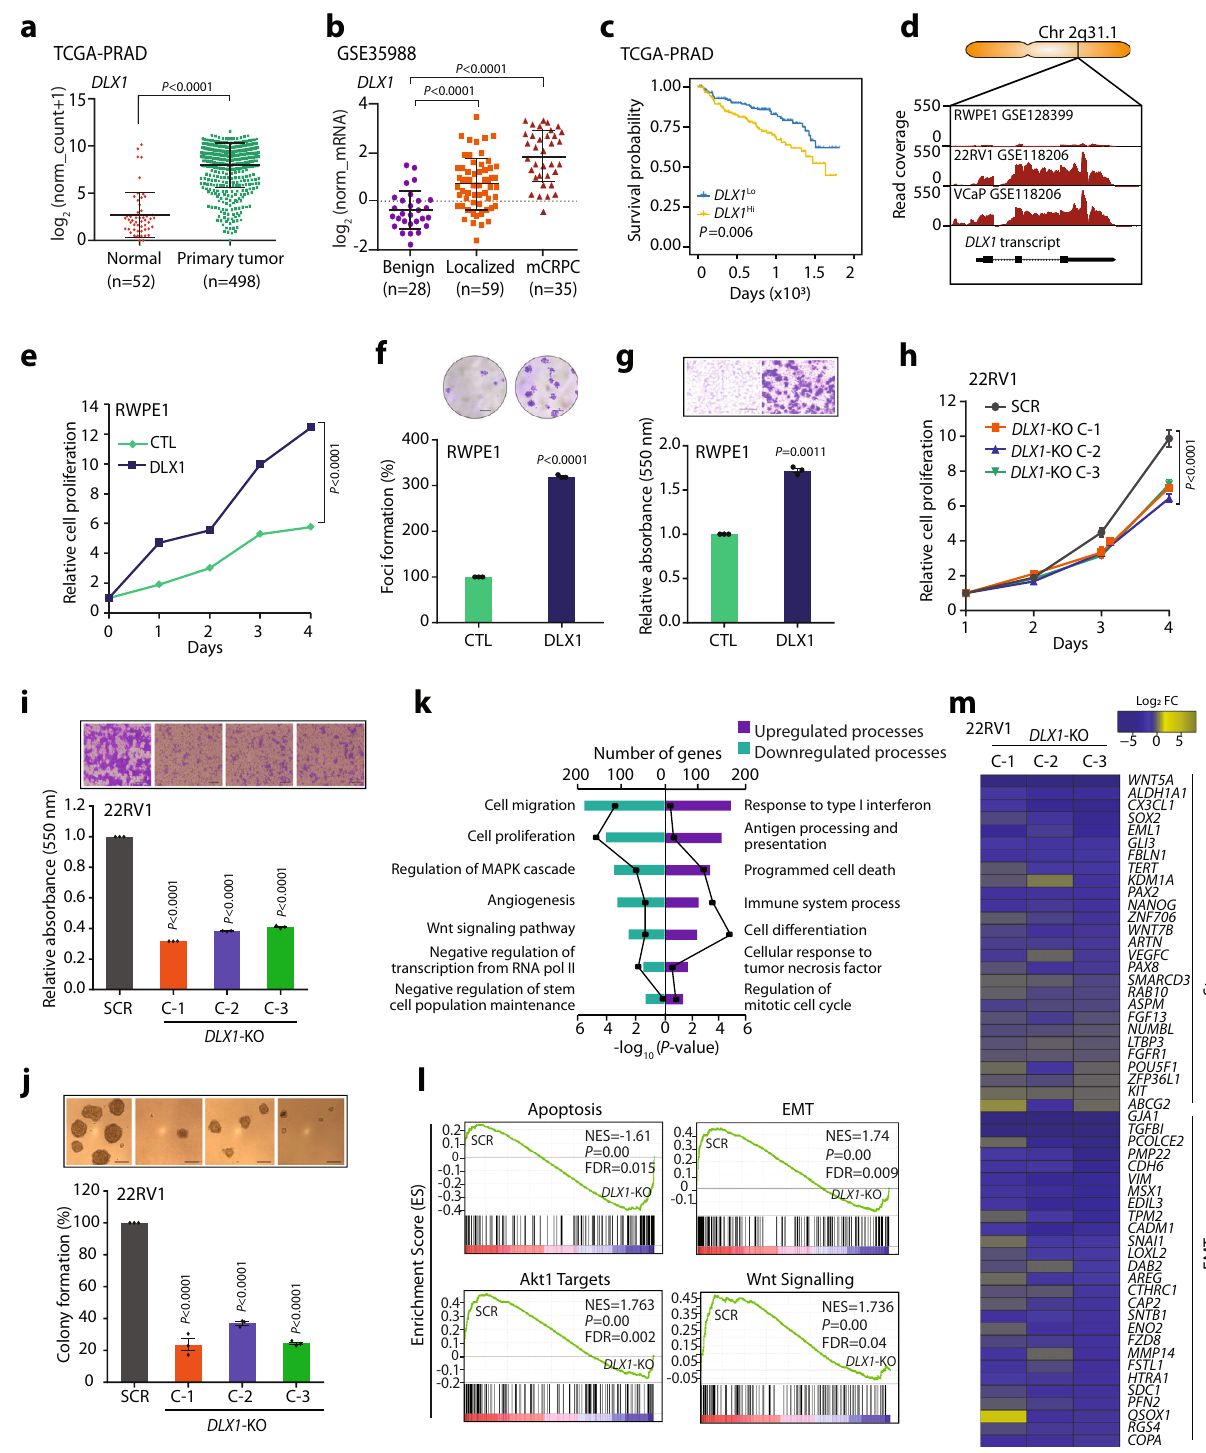
(Supplementary Fig. 1h). In addition, GSEA and pathway analysis of the differentially expressed genes showed deregulation of important pathways associated with cancer, such as upregulation of apoptosis and cell cycle arrest (Supplementary Fig. 1i, j). Further, functional characterization of differentially expressed genes in the 22RV1- DLX1 -KO cells by an overlapping network- based analysis revealed signi fi cant ( P < 0.005, FDR < 0.1) down- regulation of EMT, cell cycle and DNA damage pathways (Supplementary Fig. 2). Taken together, our fi ndings